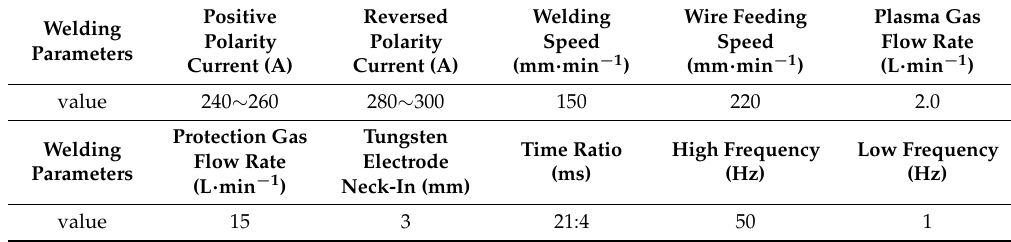
Table 3. Welding parameters of PVPPA.